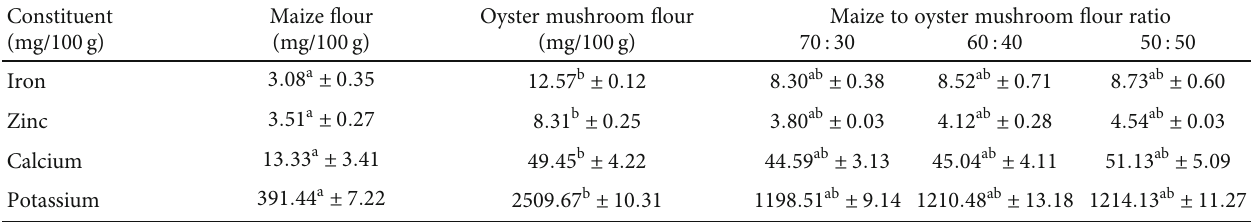
Table 2: Mineral composition of maize, oyster mushroom, and complementary fl our blends.